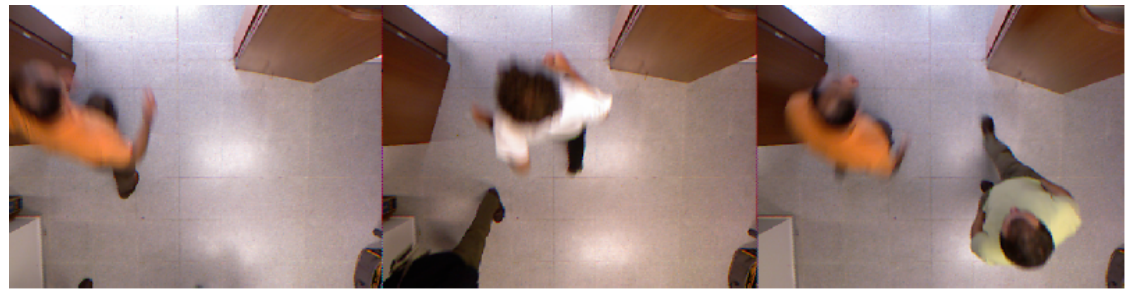
Figure 14. Trajectory middle frame of those labeled as very